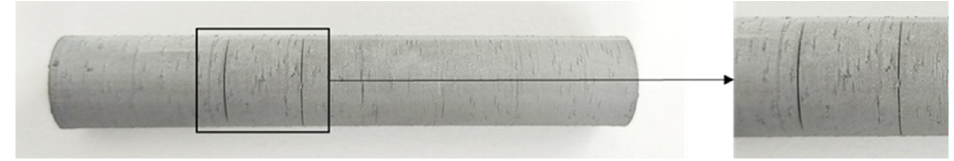
Figure 7. Cracking in the parts manufactured in experiment 2.